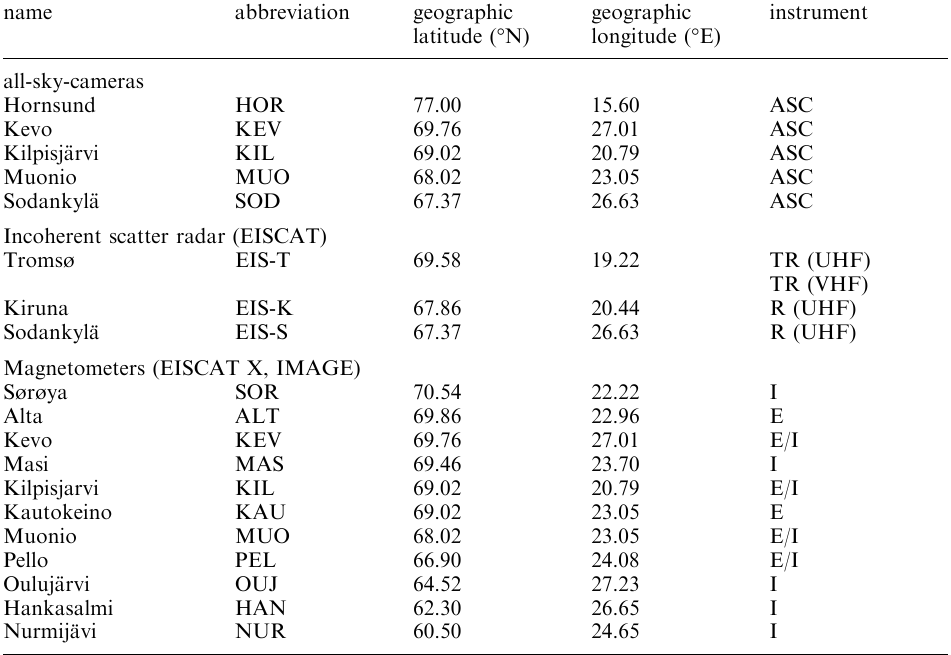
Table 1. Location of all-sky cameras, incoherent-scatter ra- dar and magnetometers (ASC: all-sky camera, TR: transmitter and receiver, R: receiver, E: EISCAT magnetometer cross, I : IMAGE magnetometer net-